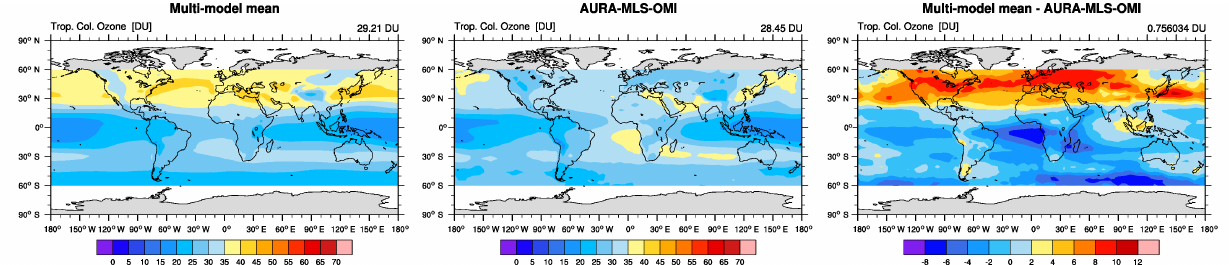
Figure 24. Climatological mean annual mean tropospheric column ozone averaged between 2000 and 2005 from the CMIP5 historical simulations compared to MLS/OMI observations (2005–2012). The values on top of each panel show the global (area-weighted) average, calculated after regridding the data to the horizontal grid of the model and ignoring the grid cells without available observational data. The comparison shows a high bias in tropospheric column ozone in the Northern Hemisphere and a low bias in the Southern Hemisphere in the CMIP5 multi-model mean. Similar to Fig. 13 of Righi et al. (2015) and produced with namelist_righi15gmd_tropo3.xml.